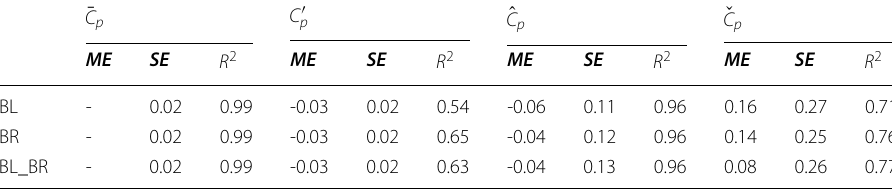
, ˆ C p and ˇ C p for LES with different mesh p